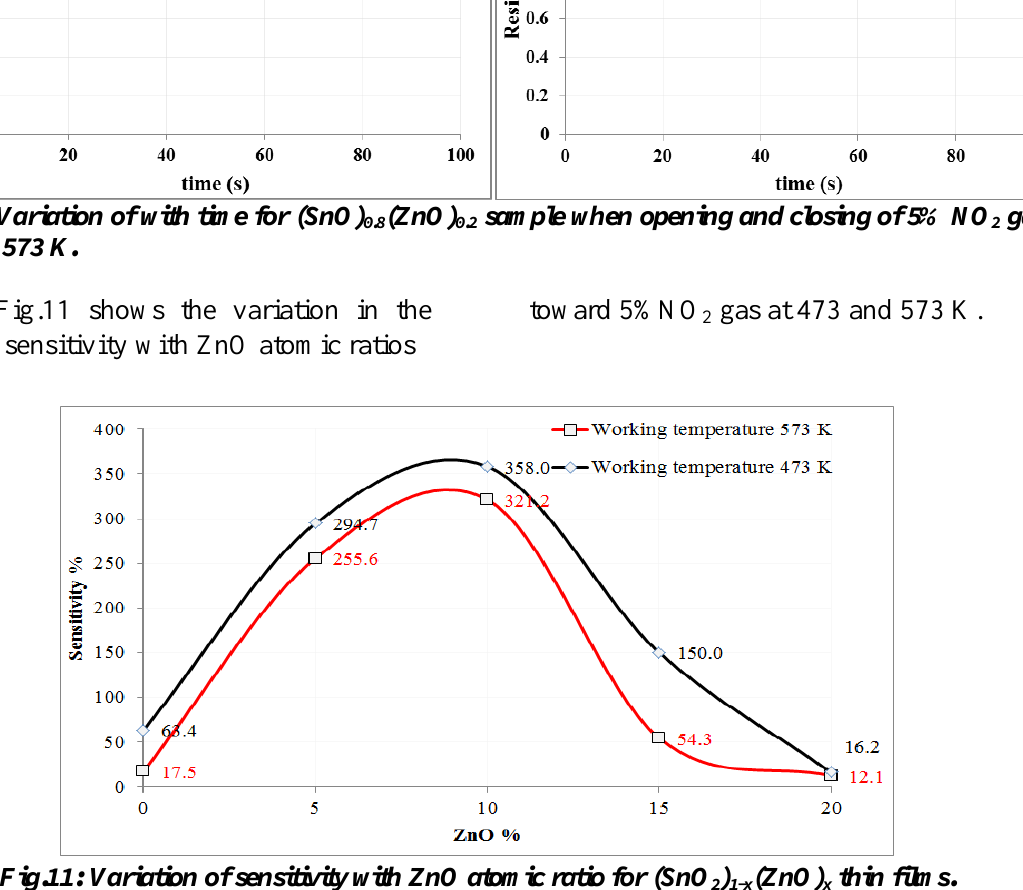
) (ZnO) thin 2 1-x x